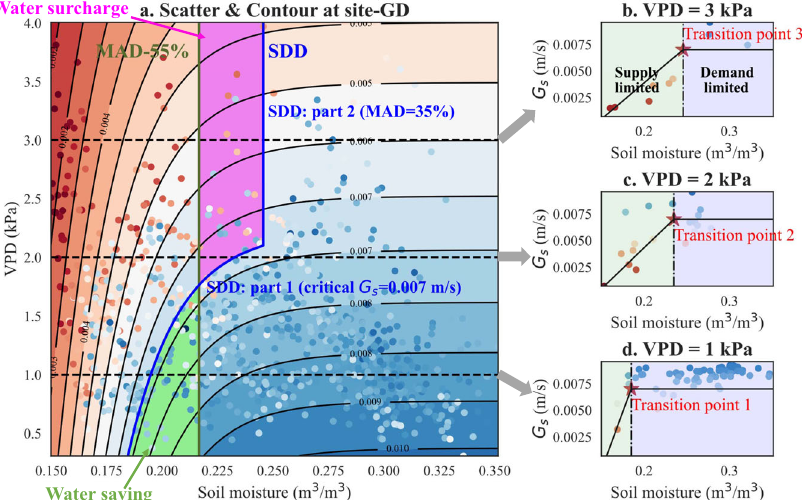
Fig. 4 Schematic diagram of plant-centric irrigation scheme based on water supply-demand dynamics at an example site- GD. SDD denotes the proposed plant-centric irrigation scheme based on water supply-demand dynamics (SDD). a Scatters of soil moisture, VPD, and canopy-level stomatal conductance ( G s ) at site-GD were simulations from the ecosys model without irrigation impacts to reproduce the co-regulation pattern. The SDD soil moisture thresholds (blue curve including part 1, i.e. contour of critical G s = 0.007 m/s, and part 2, i.e. the constant blue MAD threshold with 35%), which were the transition points between water supply (light green region) and demand (light blue region) limitations, varied with VPD. b the scatters of soil moisture and G s when VPD equaled 3 kPa with the transition point 3; c the scatters of soil moisture and G s when VPD equaled 2 kPa with the transition point 2; and d the scatters of soil moisture and G s when VPD equaled 1 kPa with the transition point 1. MAD-55% (olive line), performed as the benchmark, denoted the traditional soilmoisture-based management allowable depletion (MAD) irrigation scheme with constant soil moisture threshold (45% of soil available water holding capacity).